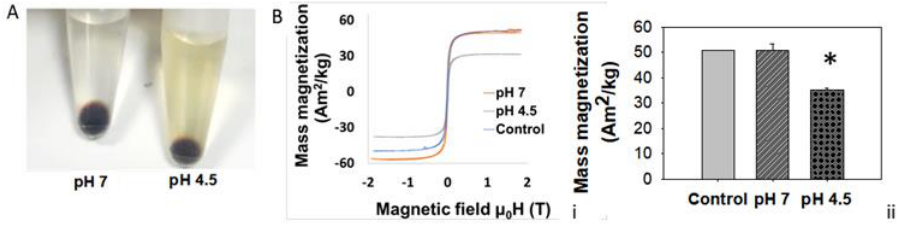
Figure 6. Magnetic properties of MNPs after incubation in acidic medium. ( A ) Photographic ob- servation of MNPs, after an incubation period of 24 h at 37 °C in the neutral solution DIW (pH = 7) or acidic medium mimicking lysosomal environment (pH = 4.5). The pale yellow color in the acidic medium (pH = 4.5) indicates the degradation process. ( B ) pH-dependent magnetization measure- ments. ( i ) VSM (Vibrating sample magnetometry) results. ( ii ) Results presented as means ± S.D. of three independent experiments. * Asterisk indicates a statistically significant difference compared to control (Student’s t -test, p ≤ 0.0 5).